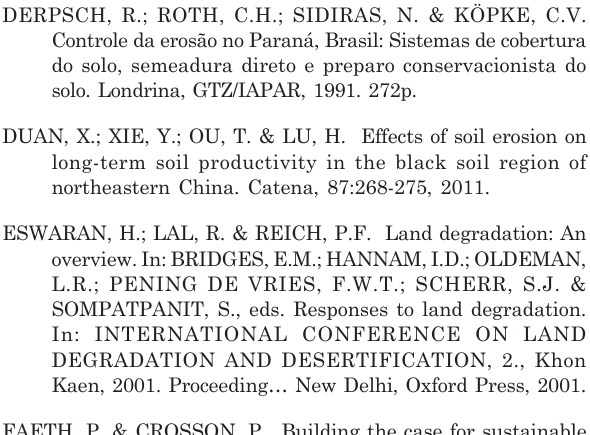
(1) Corresponding to the period between April of the first year and March of the following year. (2) BS: bare soil; WF: winter fallow; M+VB: intercrop maize - velvet bean; M+JB: summer consortium maize - jack bean; FR: forage radish; RG+CV: winter consortium ryegrass - common vetch; GL: grassland. (3) The periods in treatments BS and M+VB were not compared since no significant changes in water runoff rate over years were detected by regression analysis (Figure 2). Means followed by the same lowercase letter for the same period in the comparison among all treatments (a,b) or for the same treatment in the comparison of different periods (x,y) were not different by the LS means test (p<0.05). Means followed by the same uppercase letter for the same period are not different by the LS means test (p<0.05) in the comparison of treatments WF, M+VB, M+JB, FR, RG+CV, and GL. ns Not significant by the F test (p>0.05) in the comparison among periods at the same treatment; NS not significant by the F test (p>0.05) in the comparison of the treatments WF, M+VB, M+JB, FR, RG+CV, and GL for the same